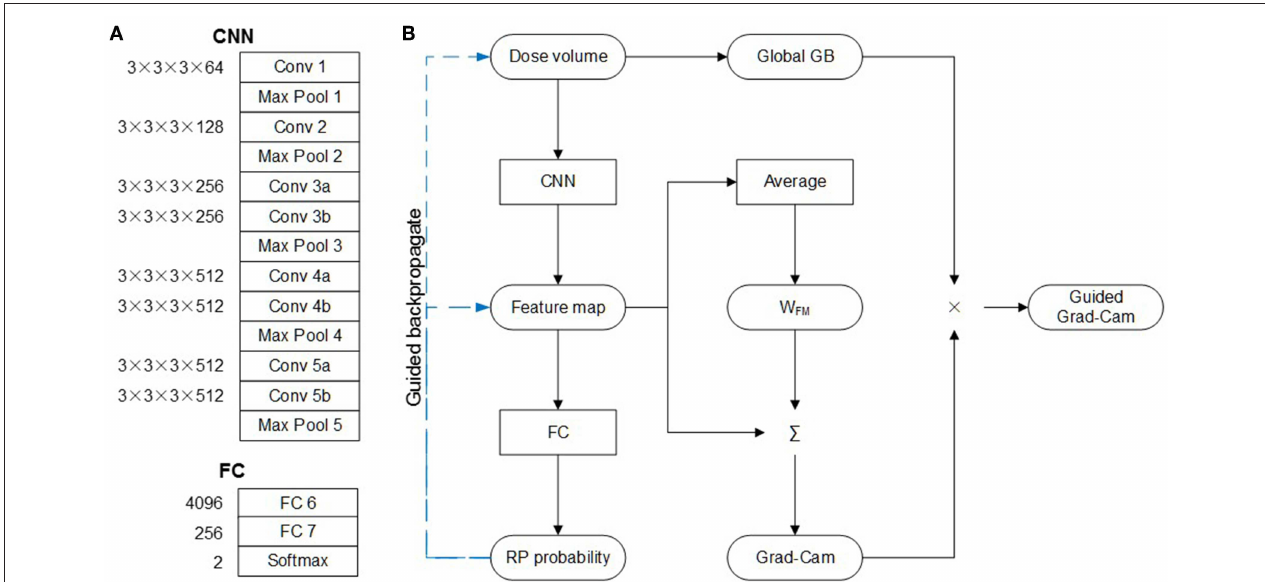
FIGURE 1 | C3D network. (A) Architecture. (B) Guided